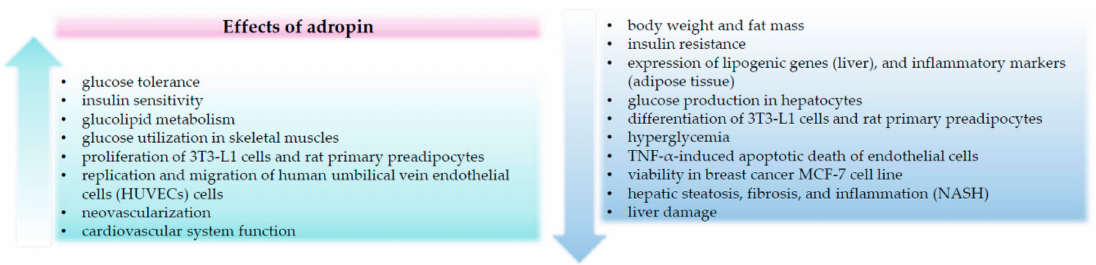
Figure 1. Summary of the biological e ff ects of